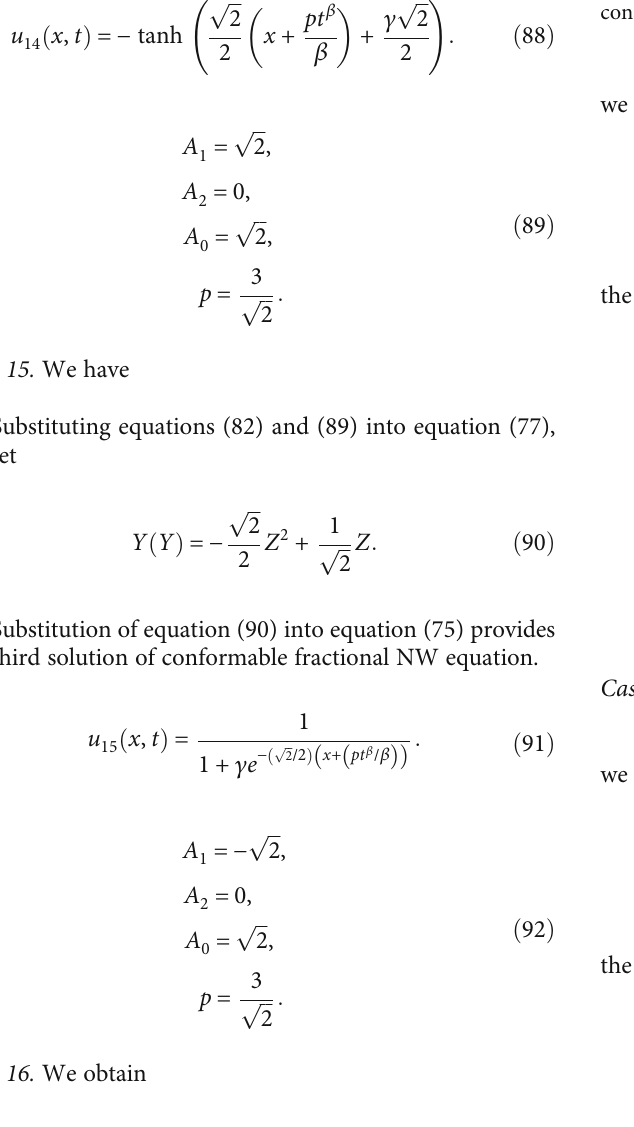
Figure 7: Conformable fractional NW equation (Case